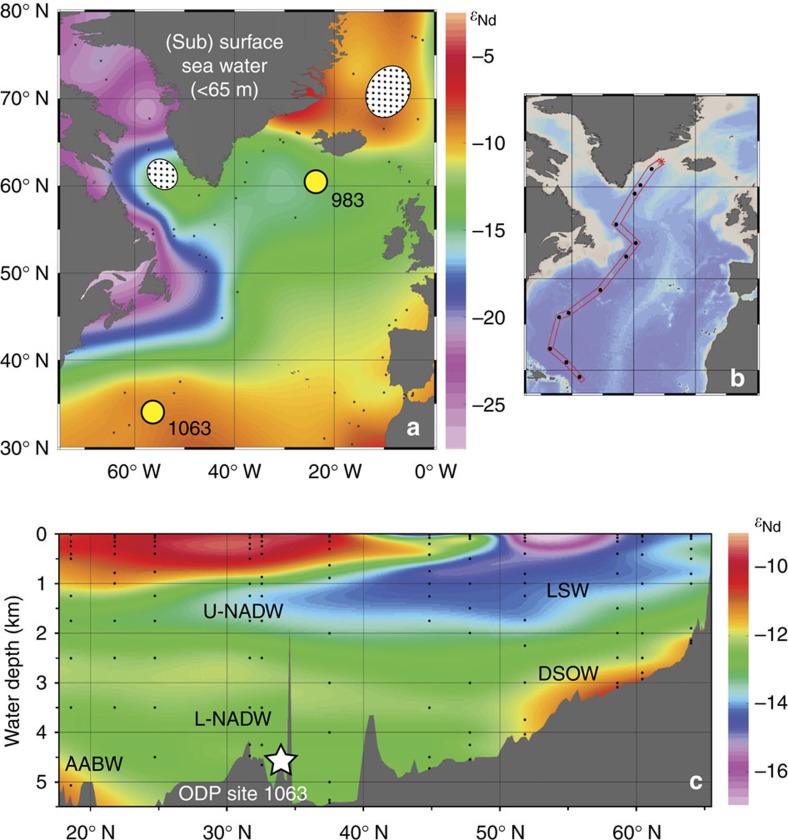
Core location and modern seawater ɛNd.(a) Map of modern near-surface seawater Nd isotopic composition (Methods section). Stippled areas are regions of modern intermediate and deep water production. Locations of ODP sites 983 and 1063 are also indicated. (b,c) Station map and seawater Nd isotopic compositions from GEOTRACES section GA02 (ref. 26) highlighting that in the modern ocean only U-NADW (intermediate water) carries a very negative ɛNd fingerprint, derived from subduction of waters in the Labrador Sea (NW Atlantic Ocean). Overflow waters from the NE Atlantic Ocean, which form the pre-cursor water masses for L-NADW, carry a more radiogenic (higher ɛNd) fingerprint. DSOW is Denmark Strait Overflow Water. ODP site 983 is bathed by ISOW (not shown), which has a similar ɛNd composition to DSOW. Map and sections created using the ODV programme (Schlitzer, R., Ocean Data View, http://odv.awi.de, 2016).